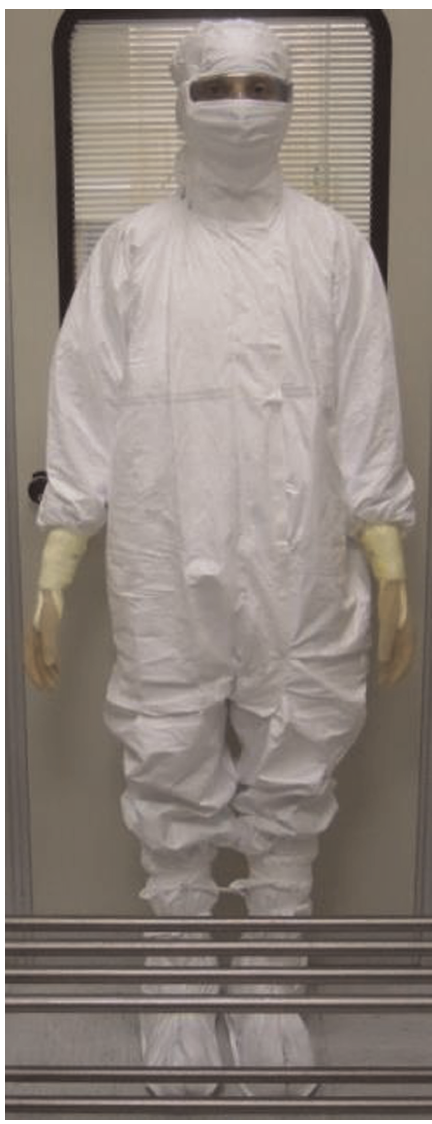
Figure 1 . Personnel should wear disposable sterile garments that both ensure protection against particles, aerosols, and liquids, and represent a barrier to